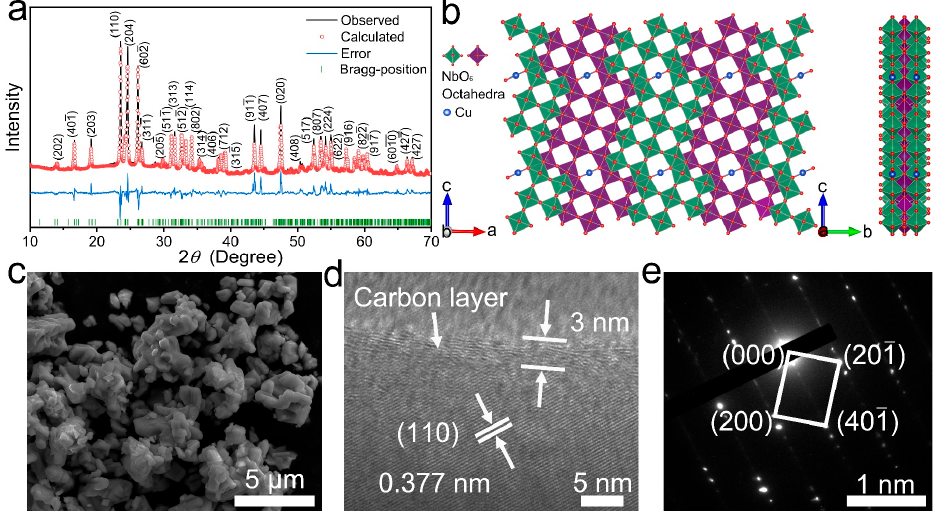
Figure 1. Physico–chemical characterizations of C-CuNb 13 O 33 . ( a ) XRD pa tt ern of C-CuNb 13 O 33 with Rietveld-re fi nement (main di ff raction peaks are labeled). ( b ) Crystal structure of CuNb 13 O 33 ( C2/m ). with Rietveld-refinement (main diffraction peaks are labeled). ( b ) Crystal structure of CuNb 13 O 33 ( c ) FESEM image. ( d ) HRTEM image. ( e ) SAED pa tt ern. ( C2/m ). ( c ) FESEM image. ( d ) HRTEM image. ( e ) SAED